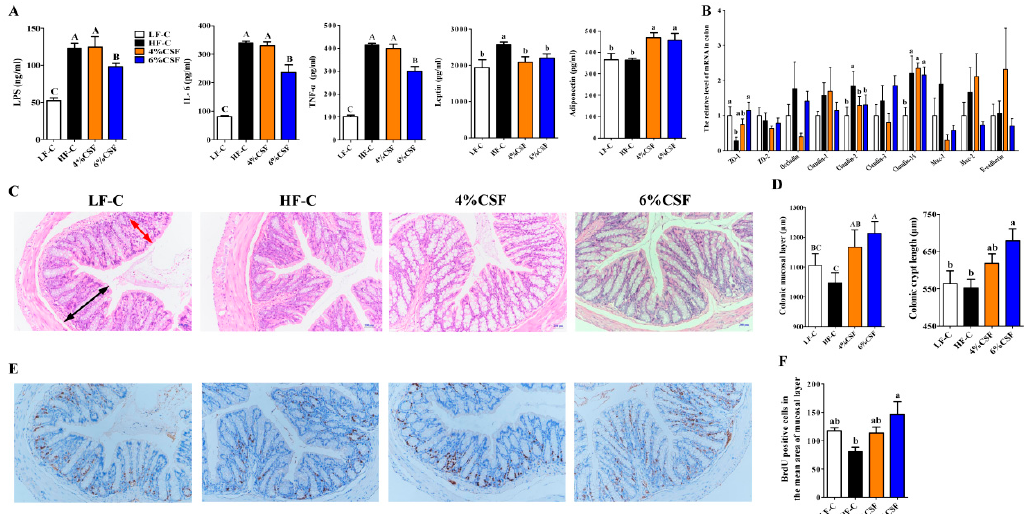
Figure 3. CSF improves the systemic inflammation and gut integrity of DIO mice. ( A ) lipopolysaccharide (LPS), interleukin-6 (IL-6), Tumor Necrosis Factor (TNF- α ), leptin and adiponectin (n = 6). ( B ) ZO-1 , Occludin , and Claudin-2 mRNA expression levels in colon tissue (n = 6–7). ( C ) Representative H&E stained images of colon tissue at 200 × magnification. Scal e bars, 200 μ m . ( D ) Quantifications of crypt length and mucosal layer thickness in colon tissue (n = 7). ( E ) Representative BrdU stained proximal colon tissue and ( F ) BrdU-positive crypt cells (n = 7). Data are expressed as mean ± SEM. Statistical significance was assessed by Tukey’s test for multiple comparisons. ab means in the same bar without a common letter differ at p < 0.05; ABC means in the same bar without a common letter differ at p < 0.01.